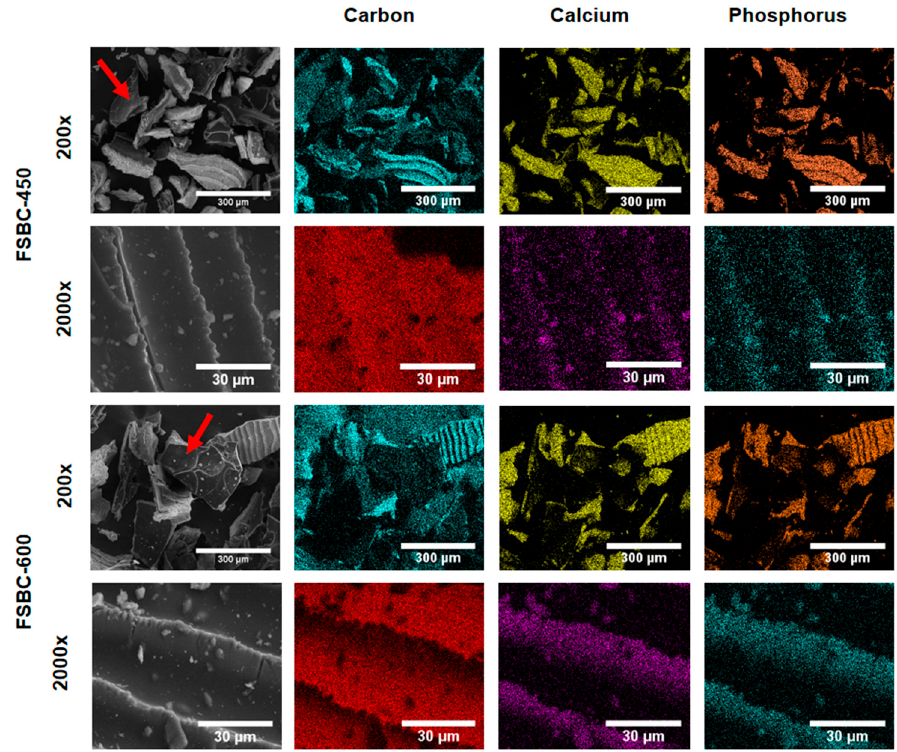
Figure 3. SEM images of FSBC-450 and FSBC-600 and their corresponding carbon, calcium, and phosphorus maps.